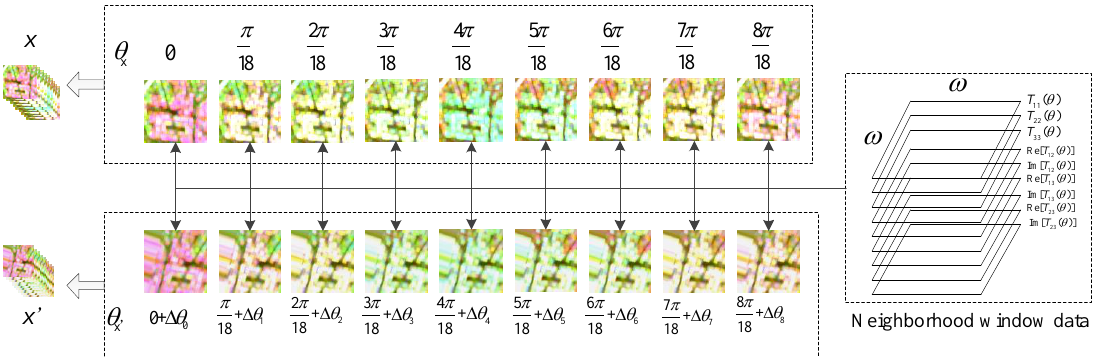
Figure 3. Input paired data x and x (cid:48) of a pixel in a polarimetric synthetic aperture radar (PolSAR) image. x denotes the sequence of polarimetric coherent matrices of the pixel’s neighborhood window. x (cid:48) is transformed from x by polarimetric matrix rotation and random geometry transformations. Each pseudo-color image patch denotes the neighborhood window data with different POAs. For every training epoch, the value of ∆ θ i , i = 0,1, · · · ,8 is randomly selected in range [ − 5 π /180,4 π /180